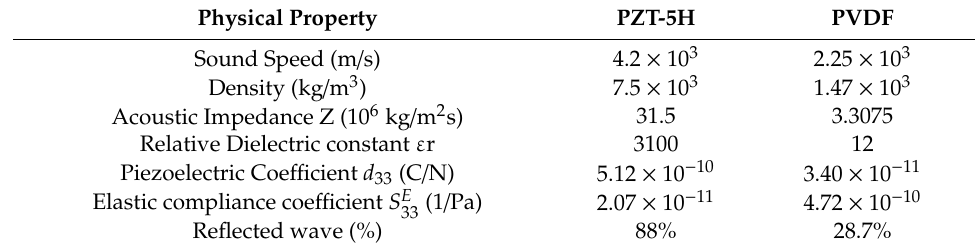
Table 1. Comparison of some characteristics of PZT-5H and polymer ultrasound transducer (PVDF)